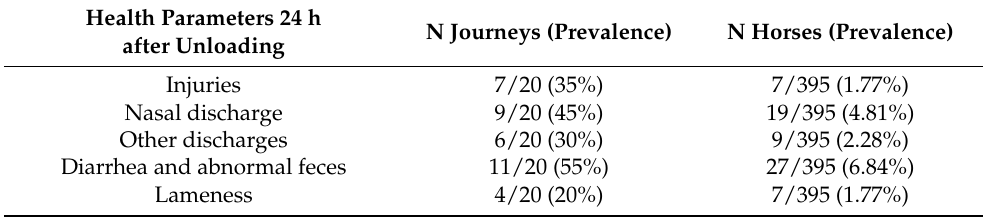
Table 11. Prevalence of health parameters 24 h after unloading for the unbroken horses ( n = 395) and 20 journeys to a slaughterhouse in Southern